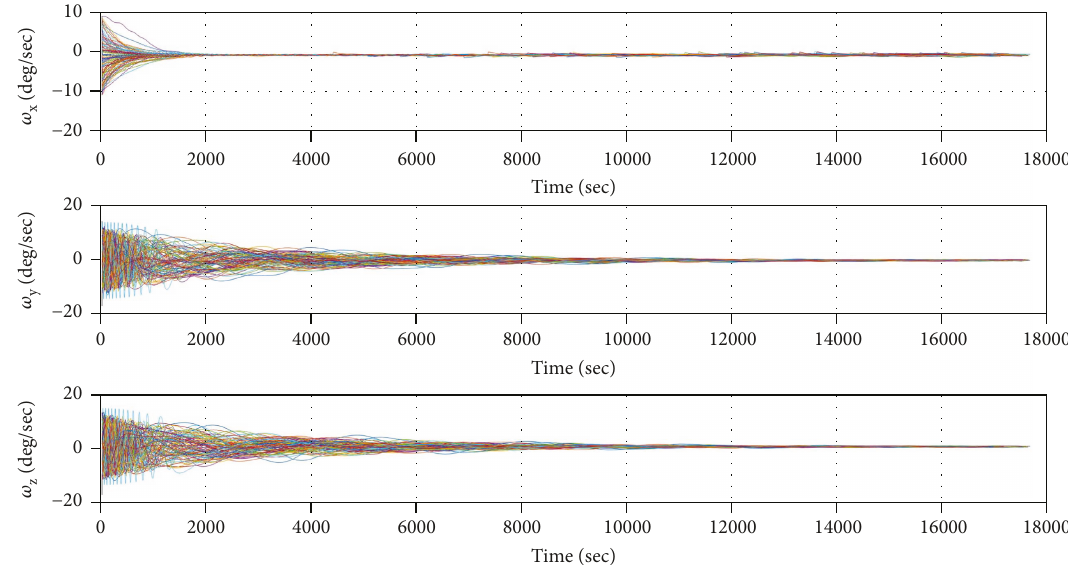
ω ω x , y , and z ) during the detumbling for 100 test cases simulated considering uncertainties on